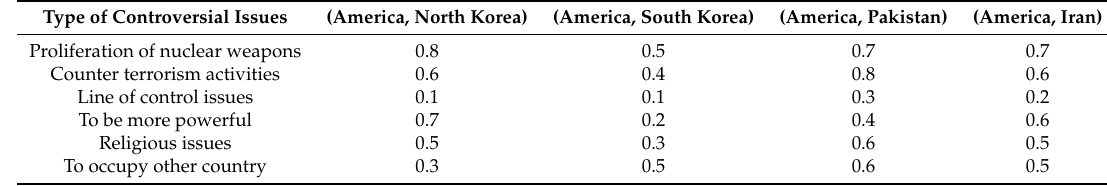
Table 2. Fuzzy set of controversial issues between America and other countries.